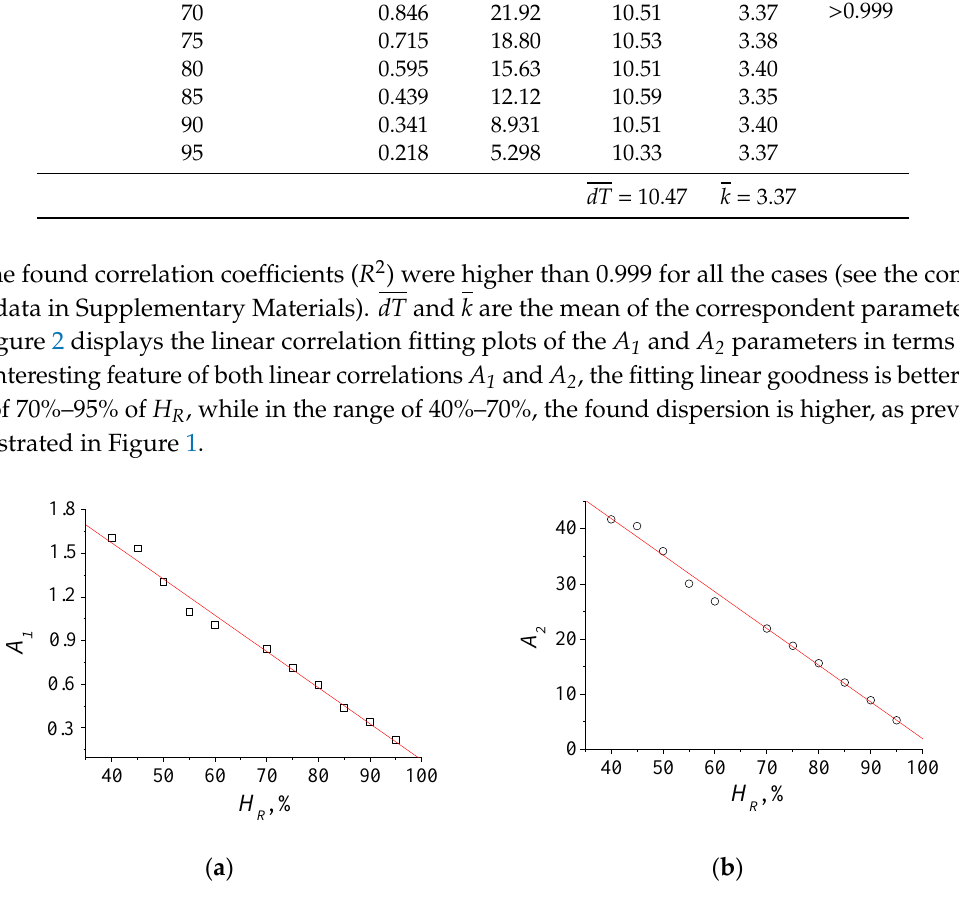
Figure 2. Linear correlation plots of the Boltzmann A 1 ( a ) and A 2 ( b ) constants in terms of H R .